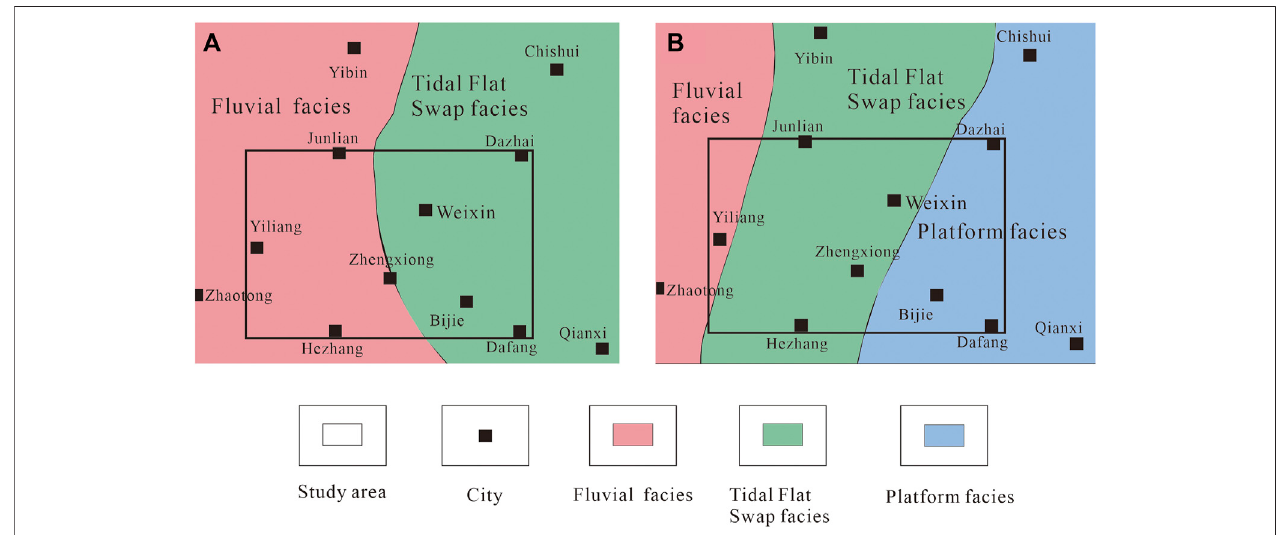
FIGURE 2 | Sedimentary stage of Leping Formation. (A) Early sedimentary stage of Leping Formation. (B) Late sedimentary stage of Leping Formation.